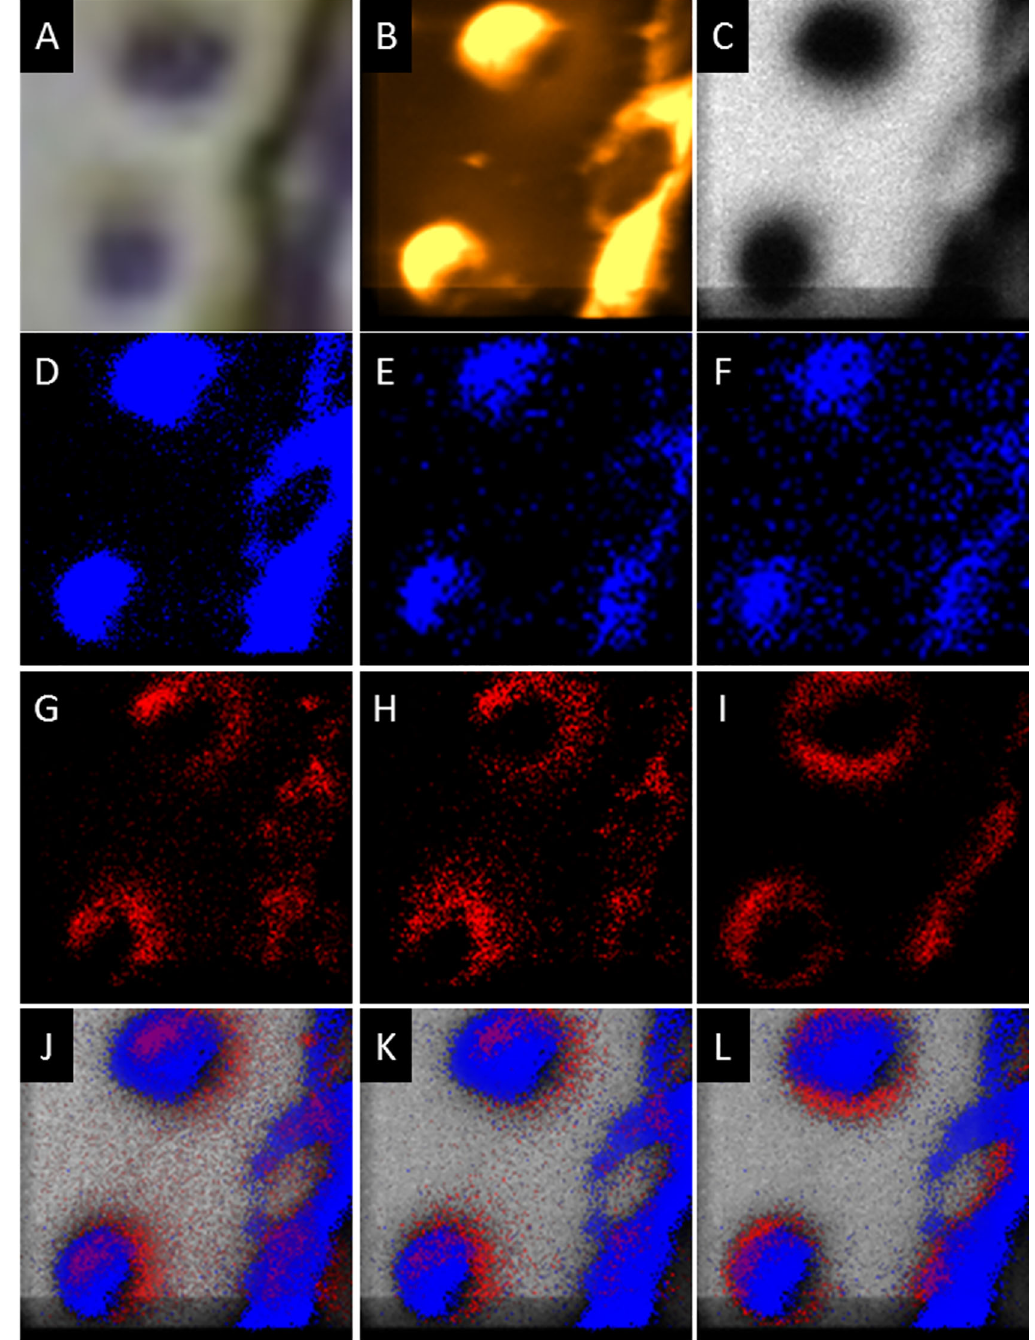
Figure 3. A) Optical image of aggregating D. discoideum cells (40 (cid:1) 40 μ m field of view). B) TOF-SIMS BA mode total secondary ion image of the same field. C-I) TOF-SIMS BA mode images pf this field at m/z C) 591 (Au 3+ substrate, light grey), D) 184, (Blue), E) 518 (Blue), F) 740 (Blue), G) 221 (Red), H) 236 (Red), and I) 240 (Red). J-L) Overlays of 591 (Au 3+ substrate, light grey), 184 (Blue), and J) 221 (Red), K) 236 (Red), and L) 240 (Red). Data are representative of 3 independent